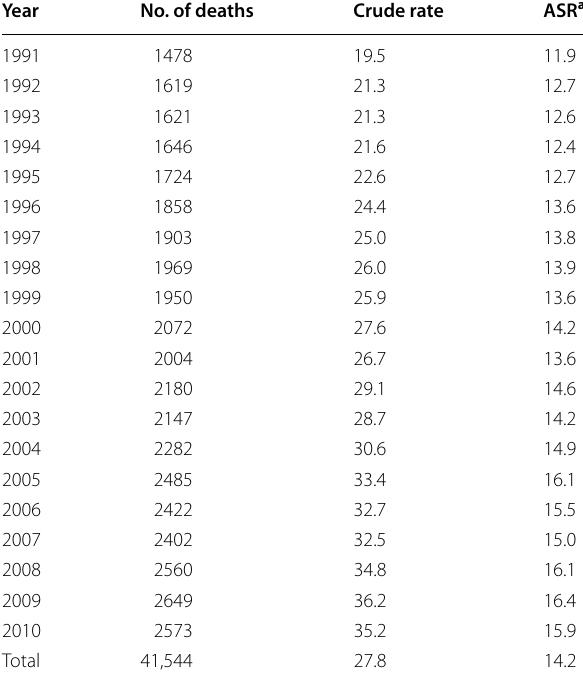
Table 1 Colorectal cancer mortality in Serbia during the period 1991–2010: number of deaths, crude rate, and age- standardized rate